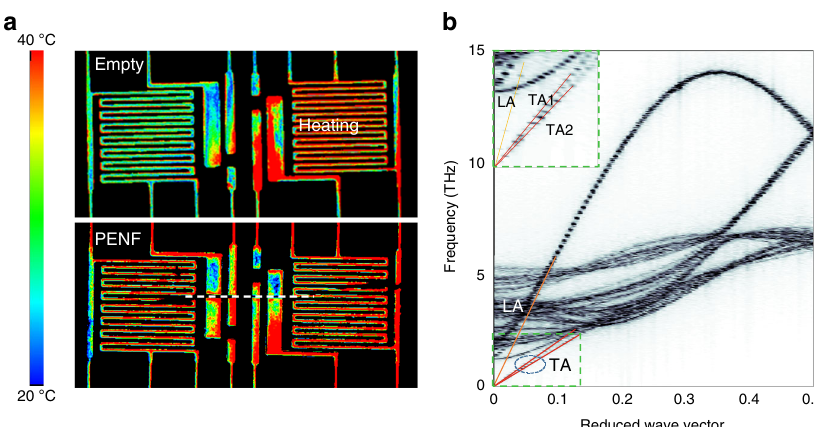
Fig. 4 Thermal transport in PENF. a Thermore fl ectance imaging of heating island (right) and sensing island (left) without a nano fi ber and a PENF respectively, in laboratory air. Dotted white line is the PENF position. b Phonon dispersion relation of the acoustic branches along the chain backbone calculated from the trajectory of MD simulations using two-dimensional Fourier transform. The contour is the raw data from calculation and colored lines are linear fi ts. The inset shows the acoustic branches close to the Brillouin